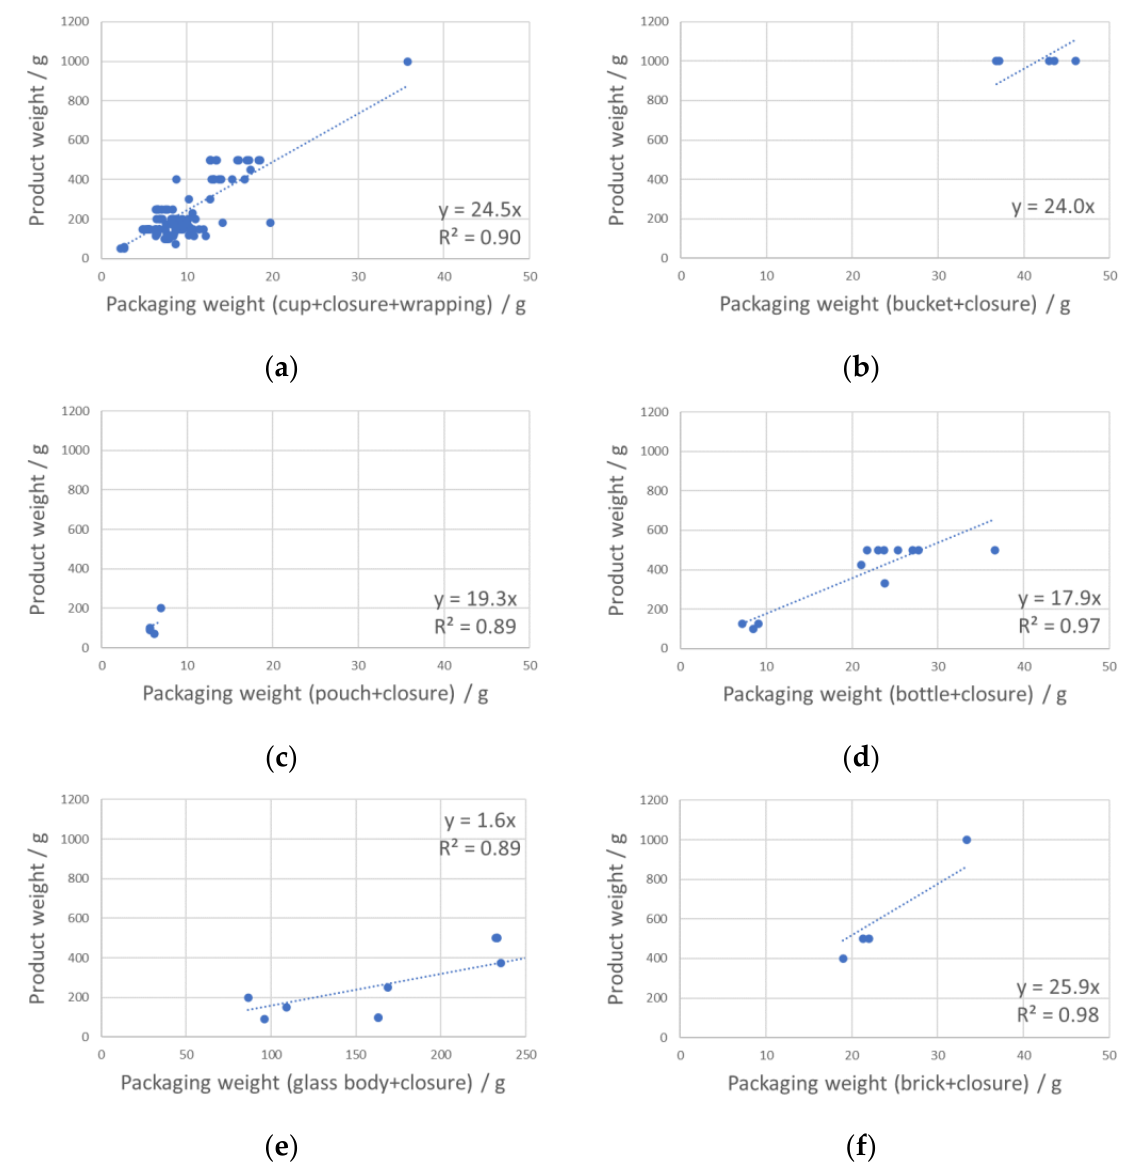
Figure 12. Food product weight (from packaging declaration) versus used packaging weight, all packaging components used (e.g., labels, wrappings, shrink sleeves); ( a ): cup, ( b ): bucket, ( c ): pouch, ( d ): plastic bottle, ( e ): glass packaging, ( f ): brick; straight line equation with origin 0 applied .